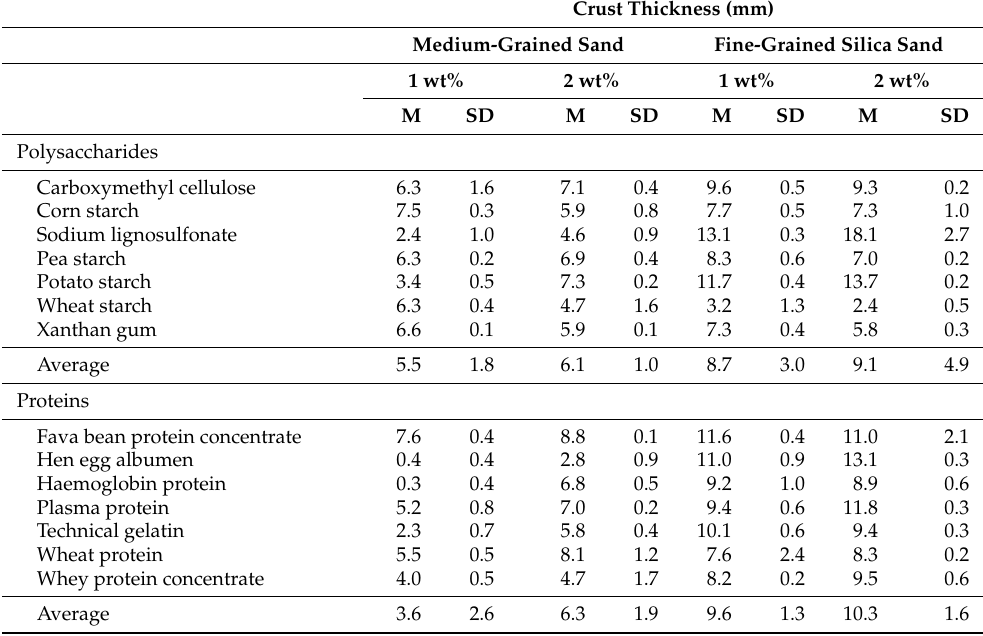
Table A5. Mean crust thickness of medium-grained sand and fine-grained silica sand samples treated at biopolymer concentrations of 1 and 2 wt% (XG = 0.25 and 0.50 wt%). Tests were performed in triplicates ( n = 3), with M = mean and SD = standard deviation. Water-treated control groups formed no crusts.